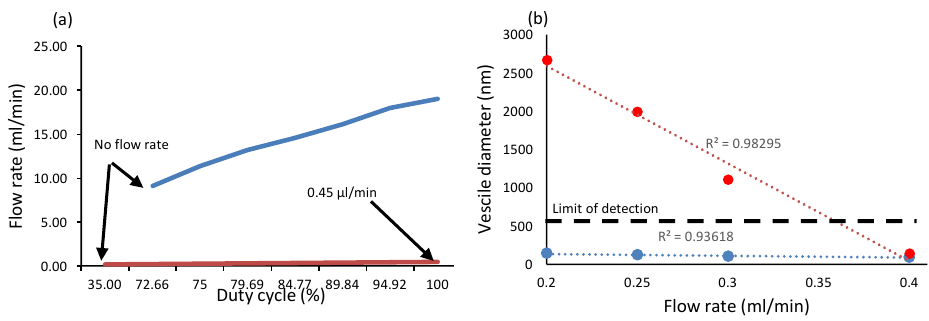
Figure S5. (a) Flow rate of two designed micropumping systems for proposed LoC system. Red and blue curves correspond to the low and high flow rate pumping system and (b) Vesicle diameter with different flow rate. Red curve corresponds to the cross shape PDMS channel while the blue colour is the pseudo-Y shape channel. In the case of the pseudo-Y channel vesicle diameter varies between 91.8 nm and 141.8 nm, which is considerably lower than the case of cross-shape.